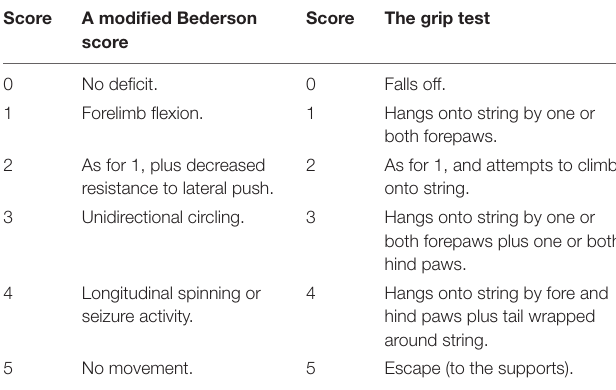
TABLE 1 | Neurological function score.